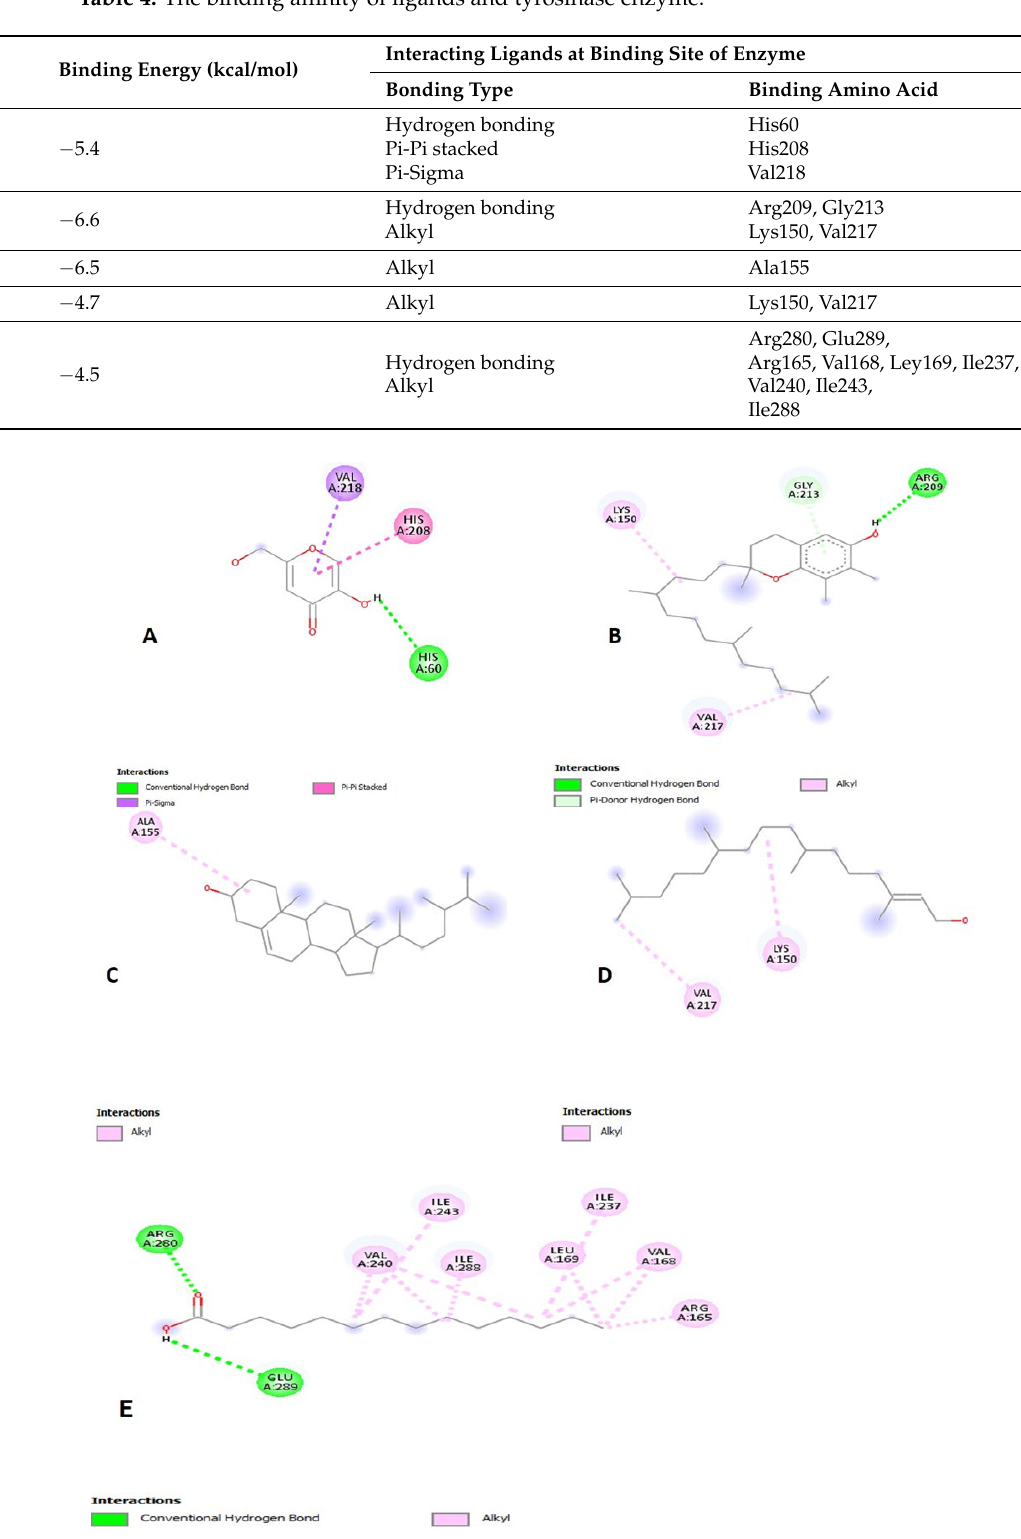
Table 4. The binding affinity of ligands and tyrosinase enzyme.